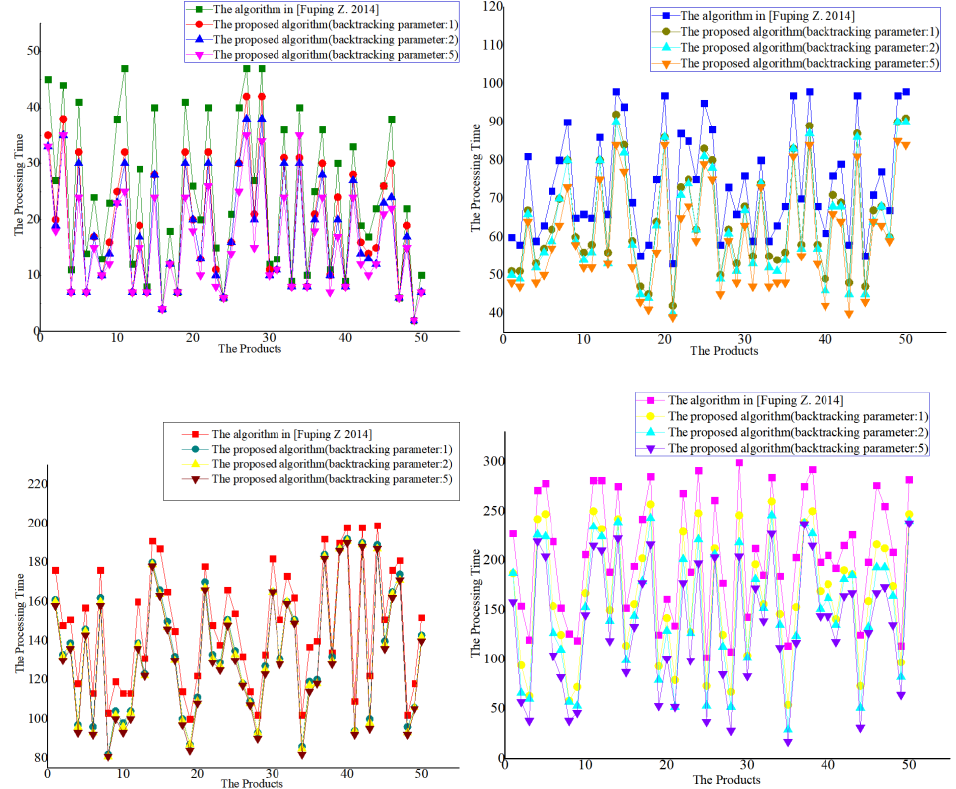
Figure 11. Comparison between the proposed algorithm and Ref. [15].